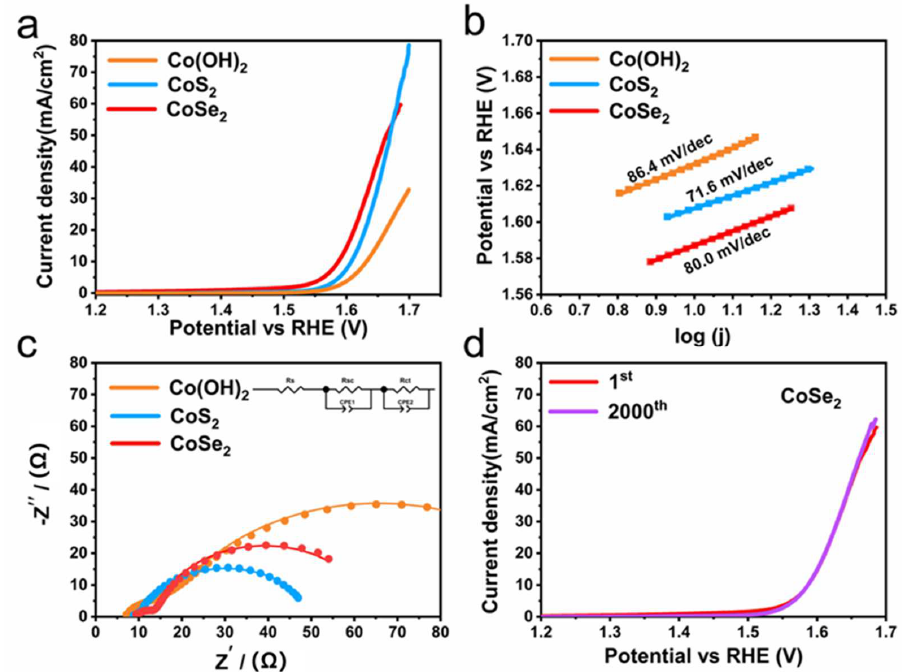
Figure 4. ( a ) OER polarization curves of Co(OH) 2 , CoS 2 , and CoSe 2 ; ( b ) Tafel plots; ( c ) Nyquist plots; ( d ) polarization curves of CoSe 2 before and after 2000 cycles.